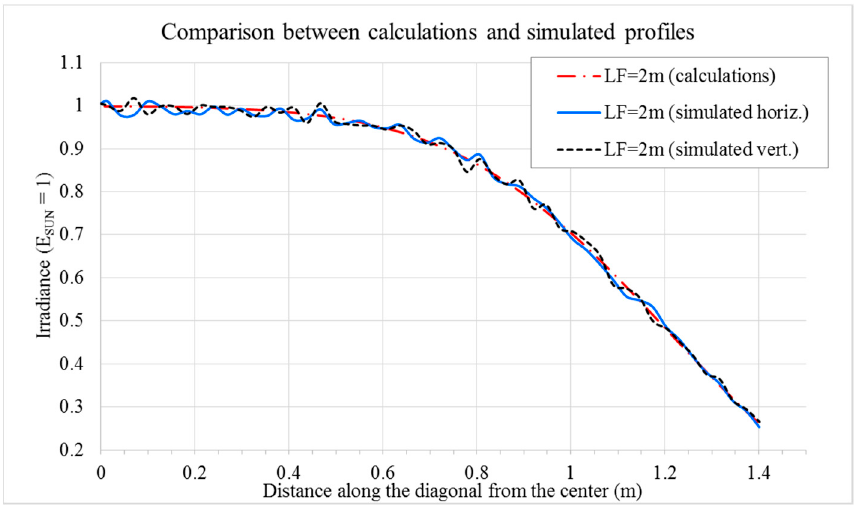
Figure 6. Comparison between simulated and calculated irradiance profiles for L F 2 m.